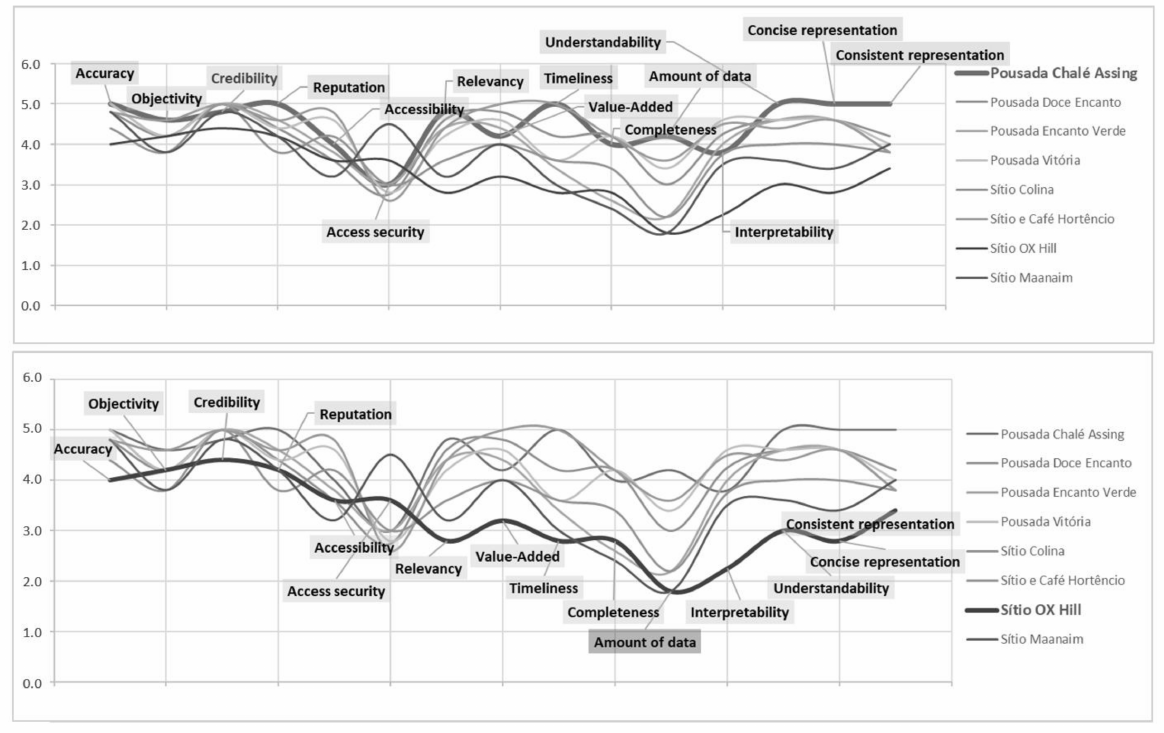
Figure 3. Representation by